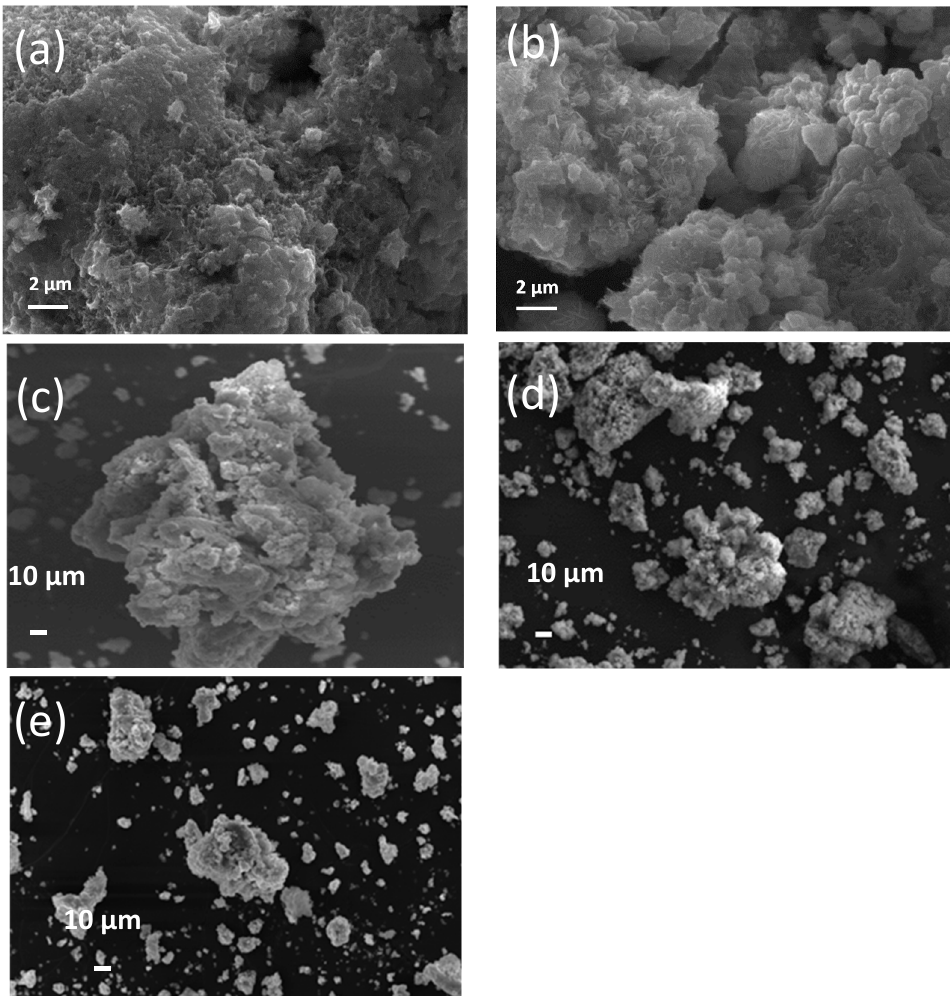
Figure 1. FESEM images: ( a ) CZA-30 ′ , ( b ) PdCZA-30 ′ , ( c ) CZA-30 ′ , ( d ) CZA-150 ′ , and ( e ) CZA-30 ′ used.